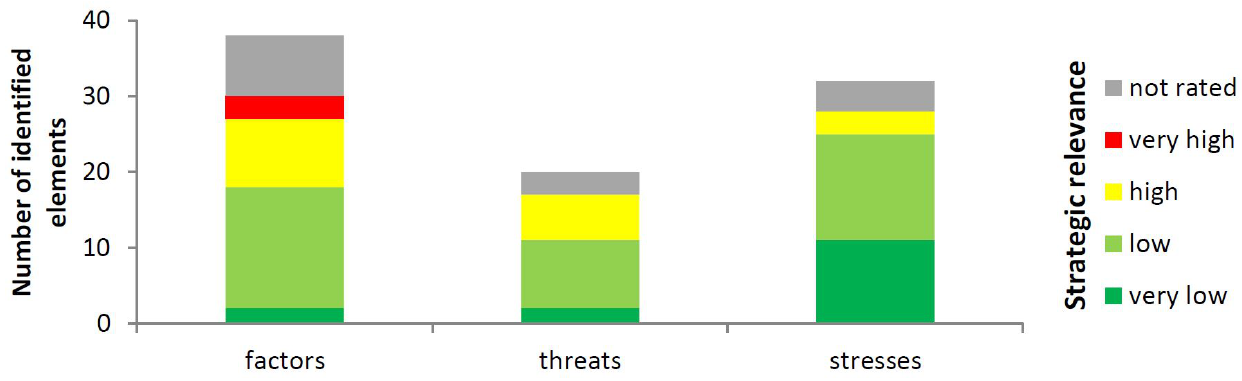
Figure 7. Distribution of values of strategic relevance rated for identified contributing factors, threats, and